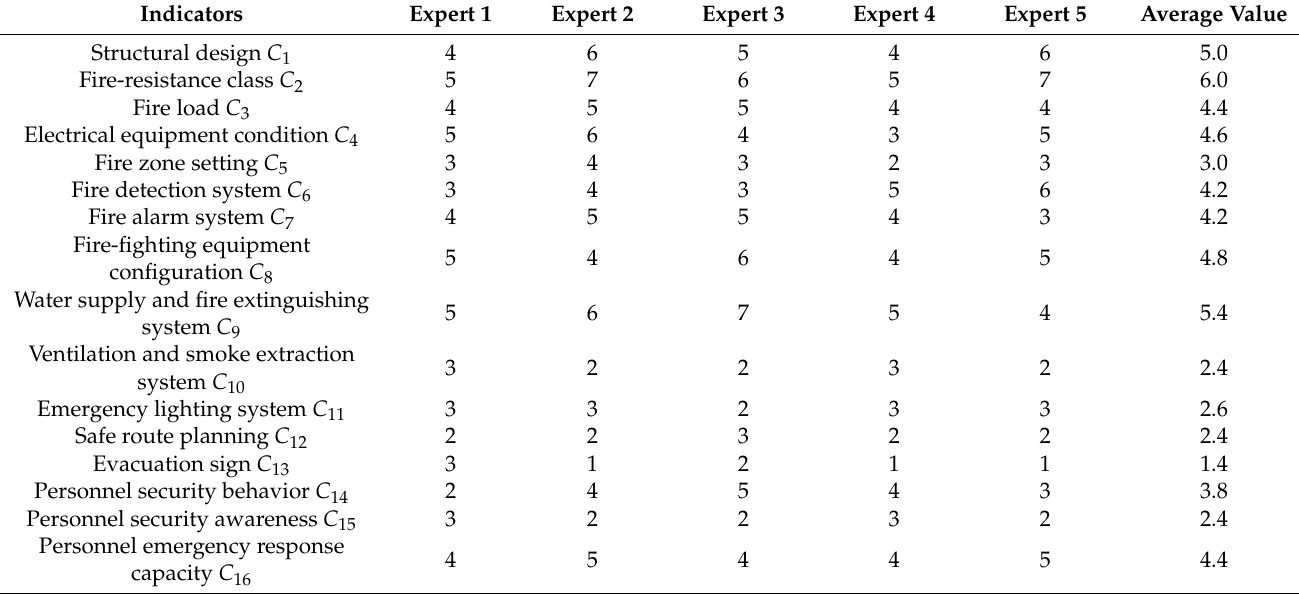
Table 3. Risk evaluation value